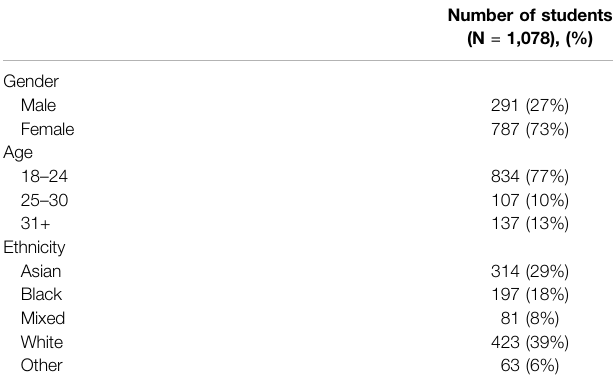
TABLE 1 | Demographics of the students who completed the survey.